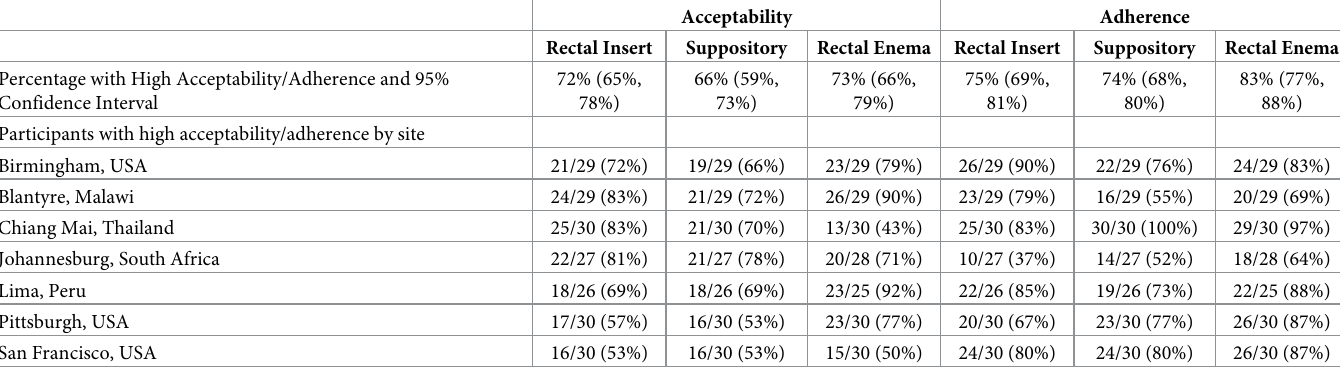
Table 4. Acceptability and adherence by study